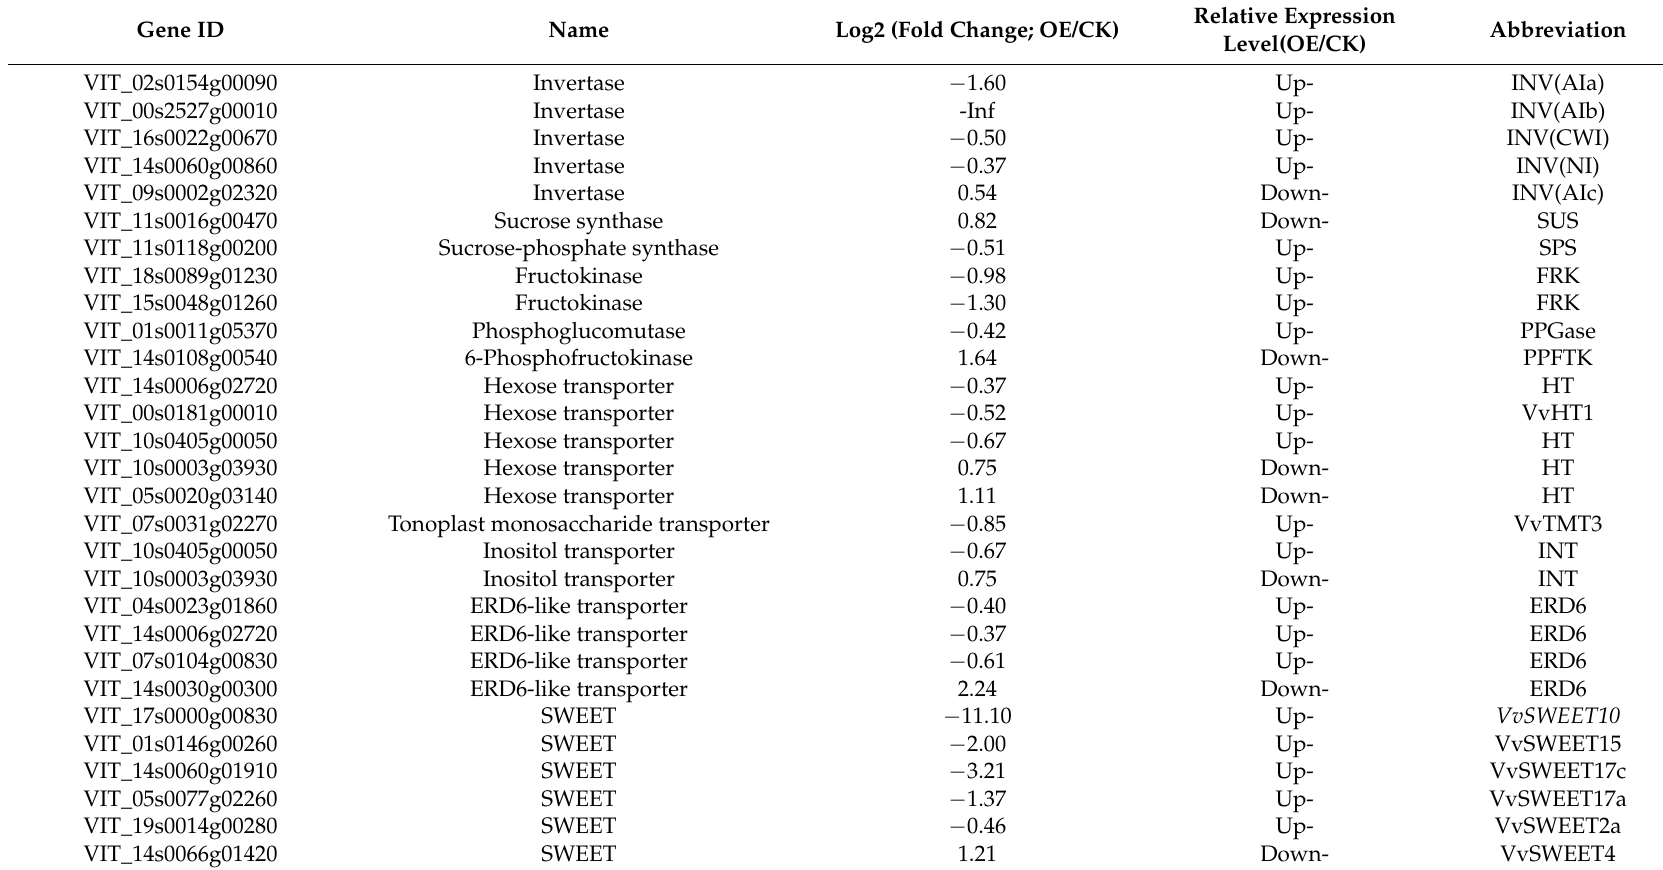
Table 1. Classification of the sugar metabolism/transport differentially expressed genes on the basis of RNA-Seq